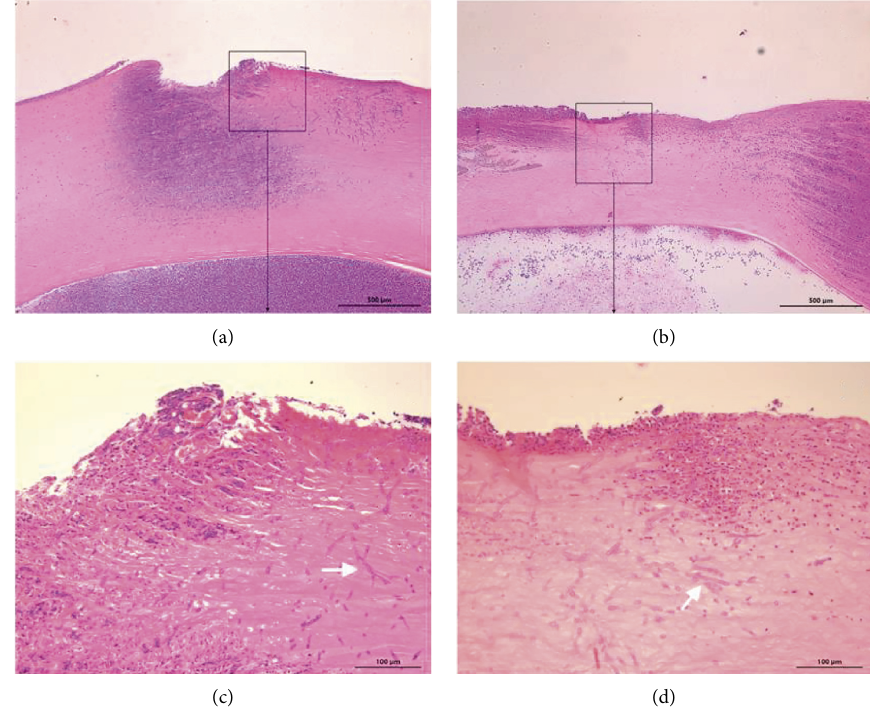
Figure 2: Histopathology of corneas in each group 3 days after corneal stroma injection. The corneal tissue of rabbit in each group was subject to HE staining. Figure (a) and (c) accelerated CXL group; Figure (b) and (d) standard CXL group. Figure (c) and (d) (X20) are the magnification of the content of the boxes in group (a) and (b) (X5), respectively; and the white arrow refers to the fungal hyphae.